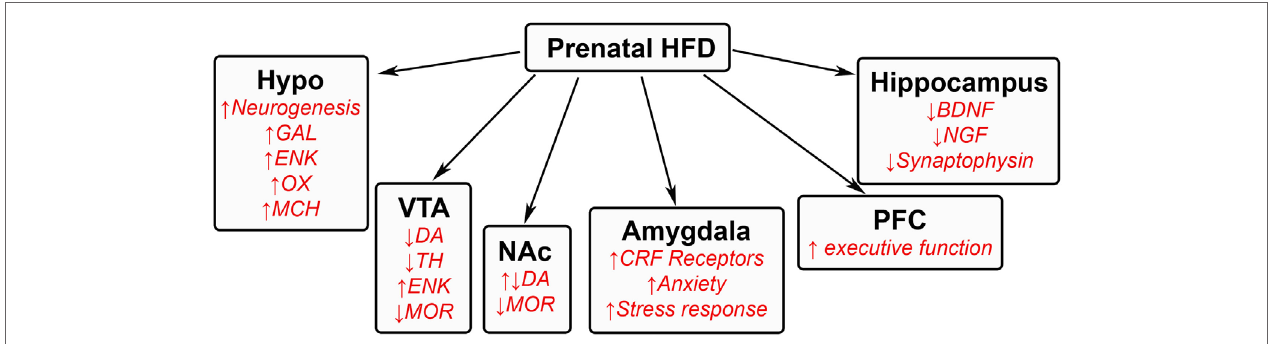
FiGURe 2 | effects of prenatal HFD exposure on offspring brain . A schematic summarizing some of the changes that occur in the brains of offspring after being exposed to a HFD during gestation. GAL, galanin; ENK, enkephalin; OX, orexin; MCH, melanin-concentrating hormone; DA, dopamine; TH, tyrosine hydroxylase; MOR, μ -opioid receptor; CRF, corticotrophin releasing factor; BDNF, brain-derived neurotrophic factor; NGF, nerve growth